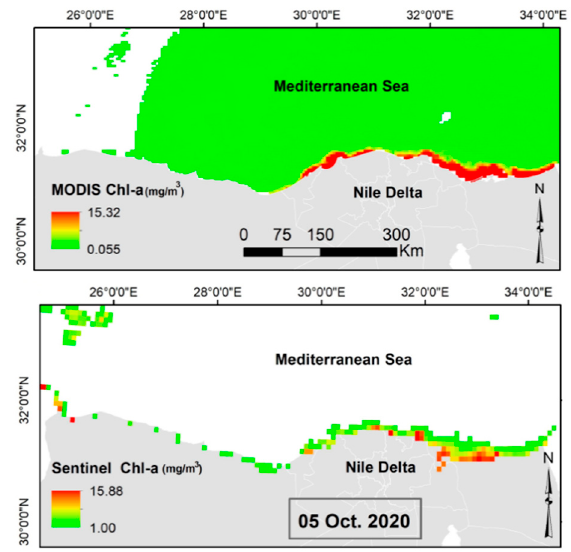
Figure 5. Example of changes in Chlorophyll-A (mg/m 3 ) on 5 October 2020 both from MODIS-Aqua and Sentinel-3 data (as an example of the data sources